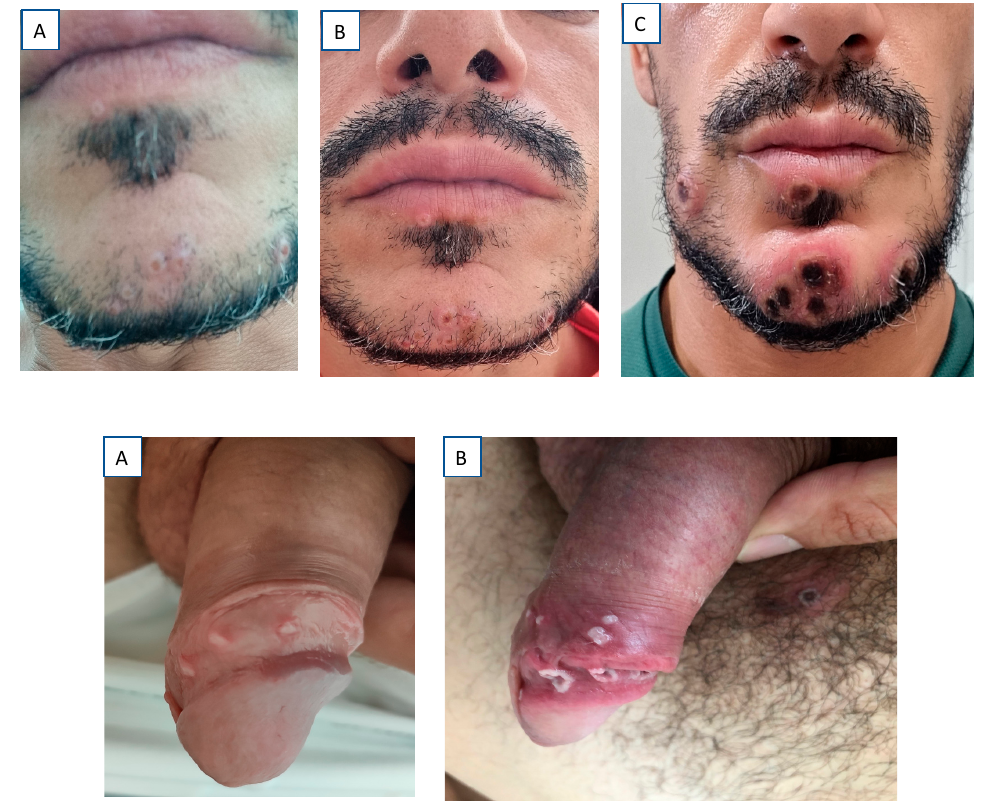
Figure 4. Synchronous evolution of lesions in two patients. Patient 1: ( A ) Day 1; ( B ) Day 3; ( C ) Day 7. Patient 2: ( A ) Day 4; ( B ) Day 8.